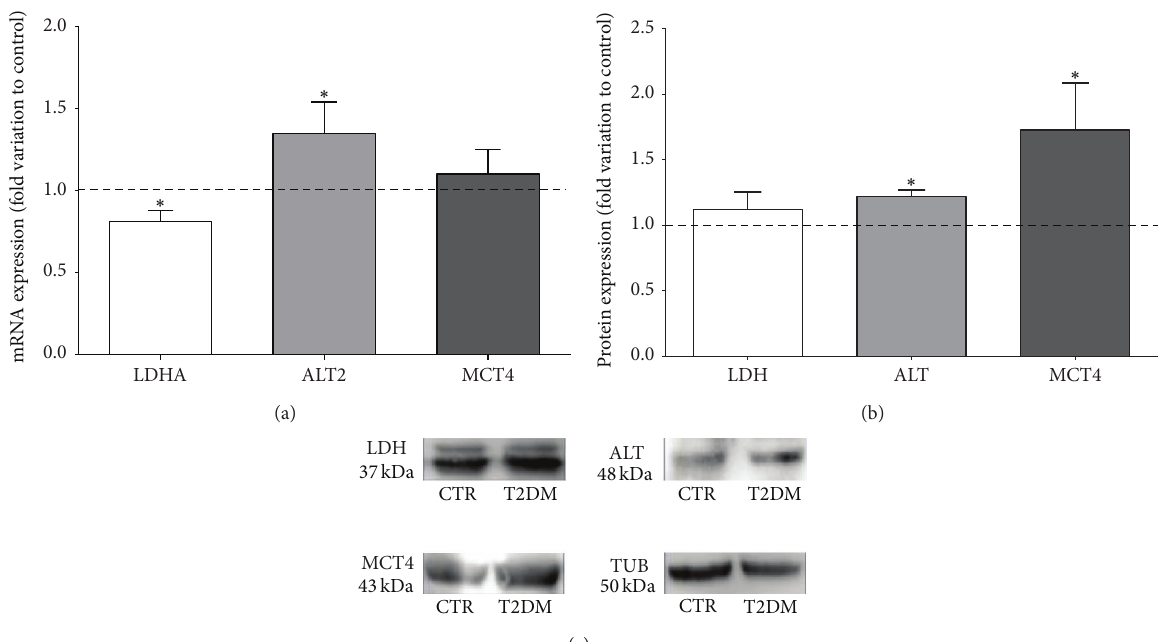
Figure 3: Type 2 diabetes mellitus (T2DM) modulates the expression of lactate production-related enzymes and transporter. (a) Pooled data of independent experiments, indicating the fold variation of lactate dehydrogenase (LDH), alanine transaminase 2 (ALT2), and monocarboxylate transporter 4 (MCT4) mRNA levels found in testicles of T2DM rats when compared with the control rats (dashed line). (b) Pooled data of independent experiments, indicating the fold variation of LDH, ALT, and MCT4 protein levels found in testicles of T2DM rats when compared with the control rats (dashed line). (c) Illustrative Western Blot experiment. Results are expressed as mean ± SEM ( 𝑛 = 6 for each condition). *Significantly different relative to control ( 𝑃 < 0.05 ).